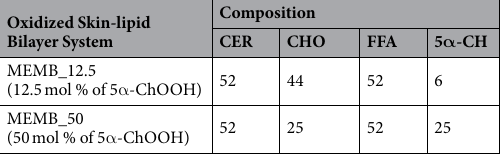
Table 1. Composition of the model membranes simulated. The total number of lipid molecules was 154 in each bilayer system with 77 in one of the leaflet and 77 in the